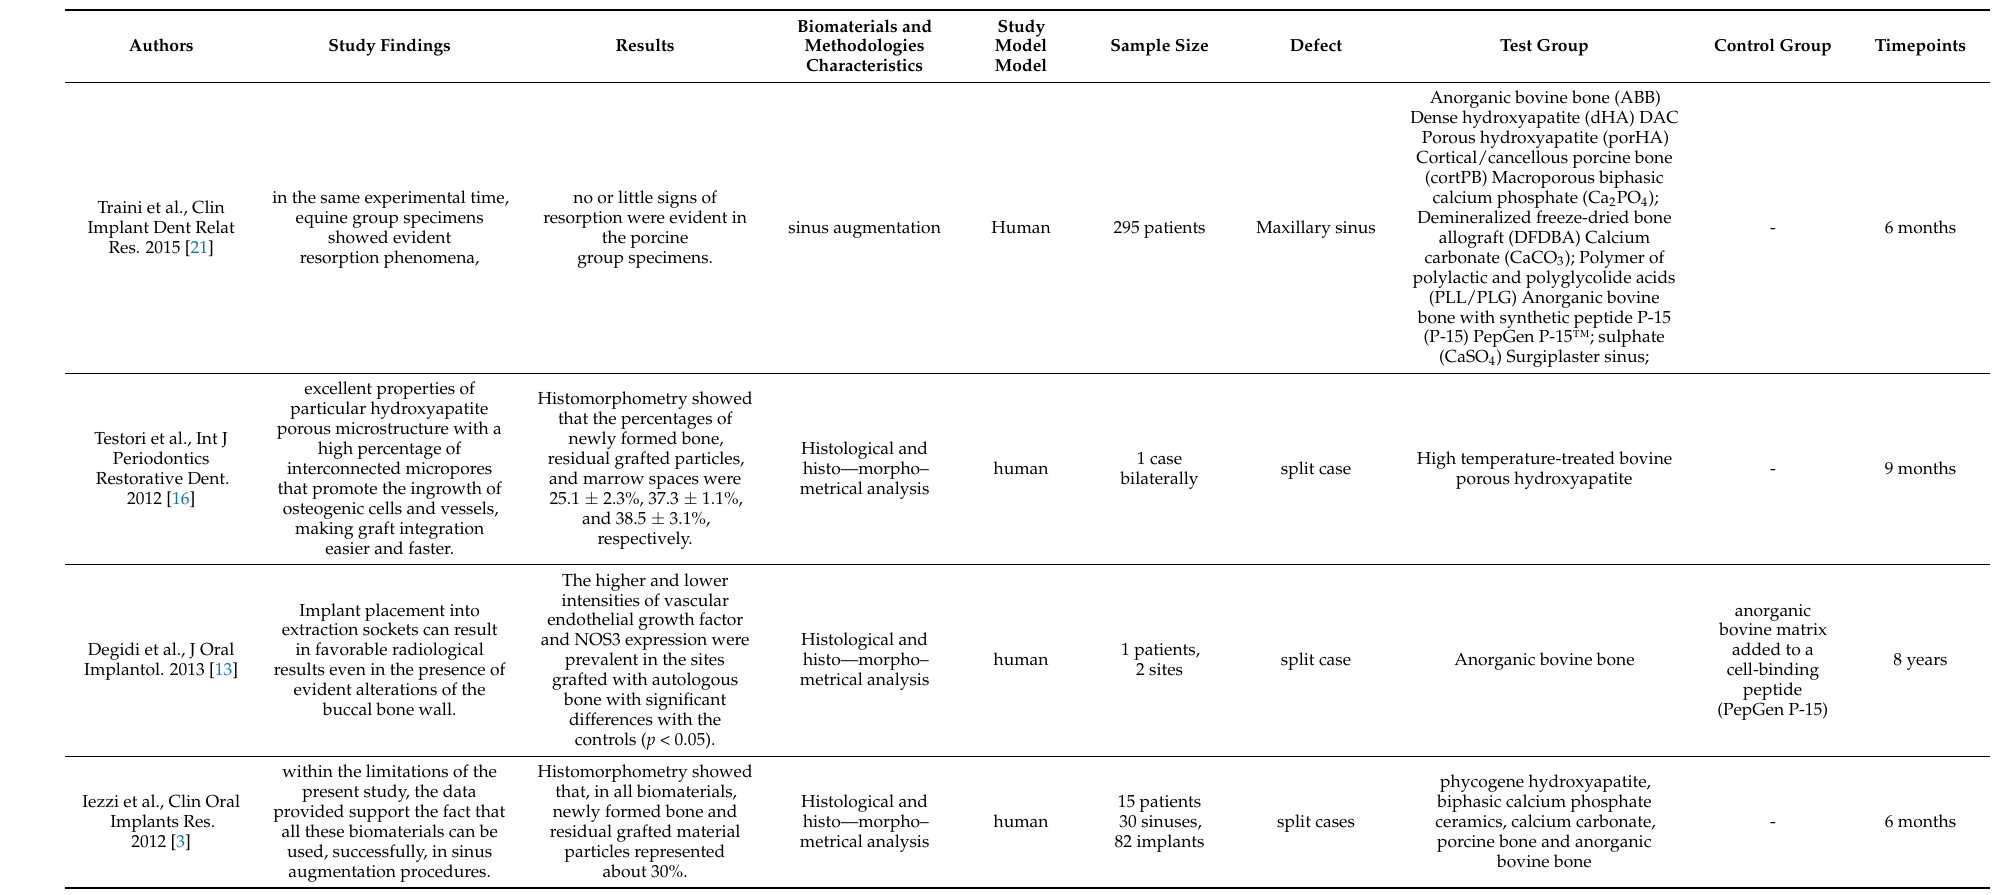
Table 1. Summary table of the anorganic bovine bone (ABB) findings of the papers